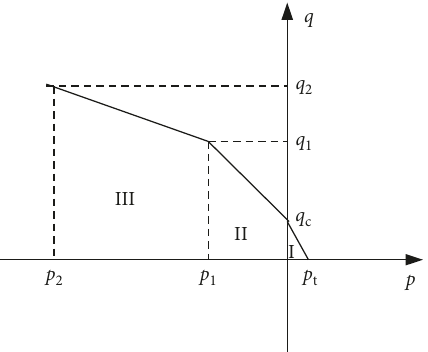
Figure 19: Graph showing the strength envelope in the q - p plane and masonry failure